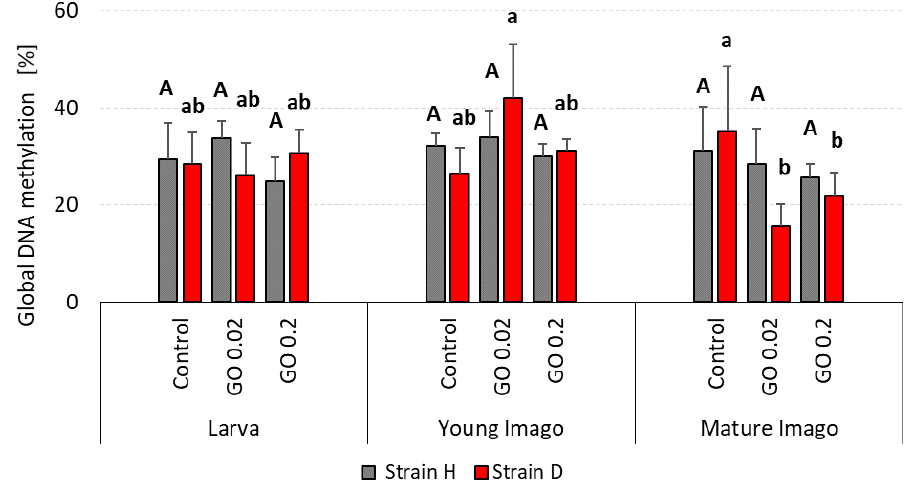
Figure 7. Global DNA methylation percentage in the gut cells of the wild (H) and long-living (D) strains of A. domesticus that had been chronically intoxicated with graphene oxide (GO). Measurements were conducted at larva (n = 5), young imago (n = 5) and mature imago stage (n = 5). Abbreviations: see Figure 1. Capital letters refer to strain H, while lowercase letters refer to strain D; asterisks indicate differences between the strains in each experimental group separately.